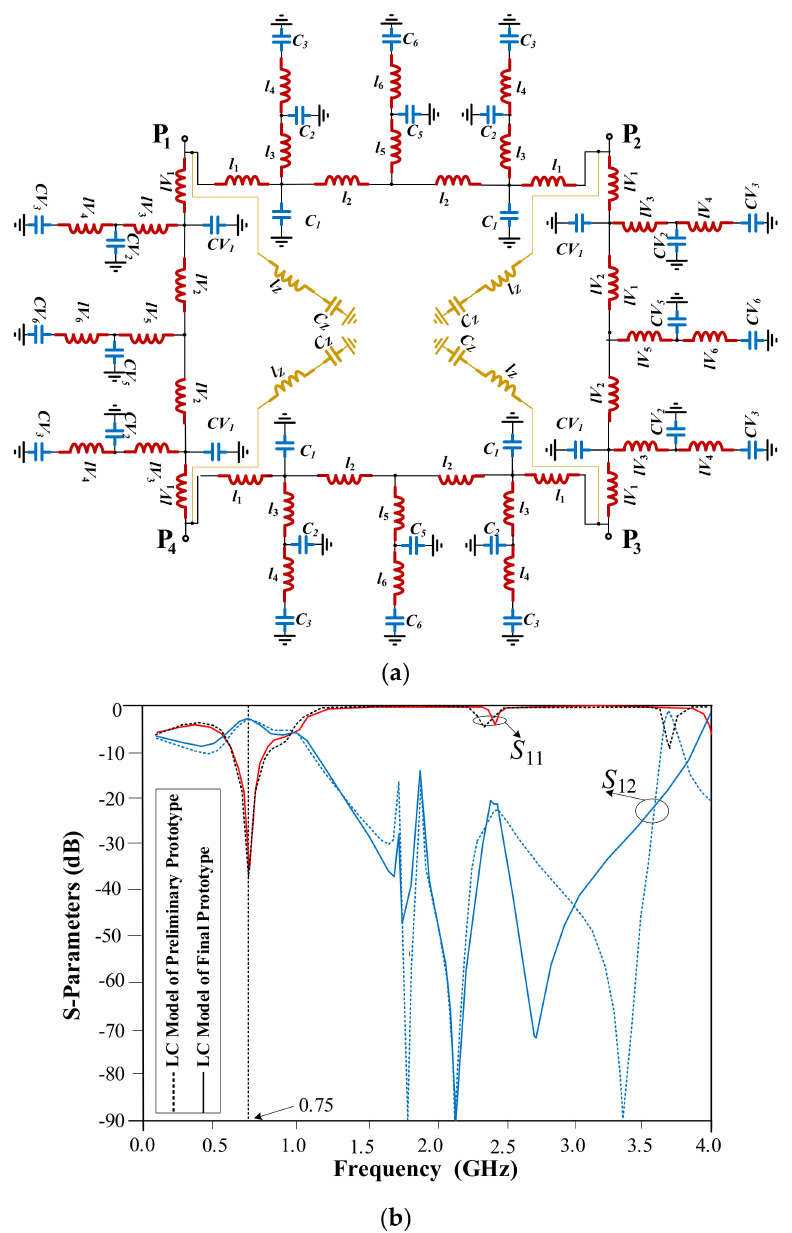
Figure 12. ( a ) The LCE models of the preliminary and the final prototypes of the coupler. ( b ) The comparison between LCE model frequency responses of the preliminary and the final prototypes of the coupler. In LCE circuit, C Z and L Z only exist in the final prototypes of the